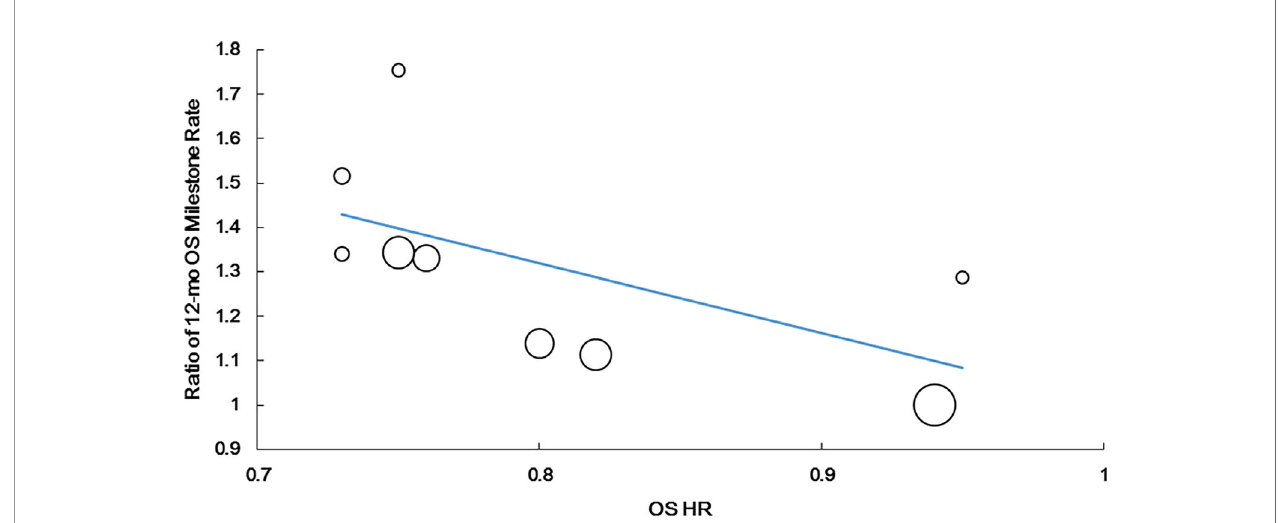
FIGURE 2 | Correlation of treatment effects on the overall survival (OS) hazard ratio (HR) with the ratios of 12-month OS milestone